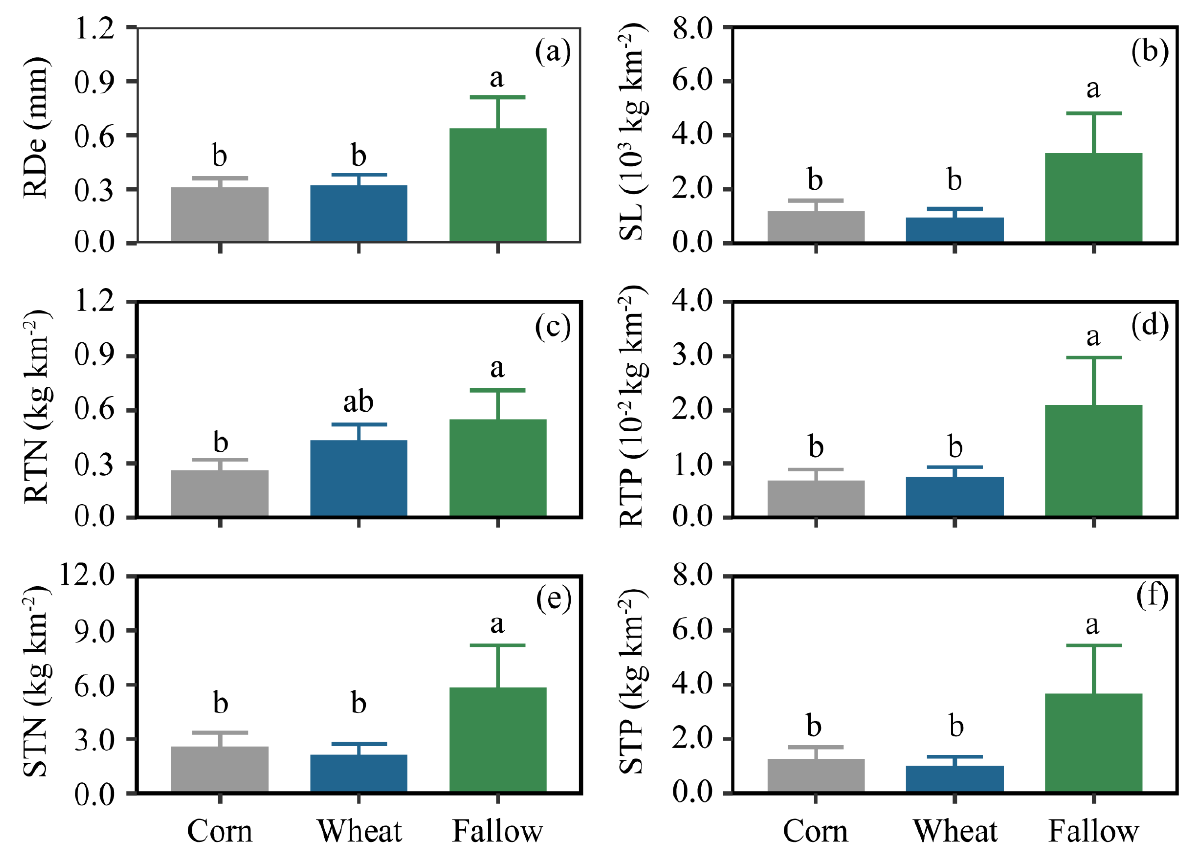
Figure 2. The ( a ) runoff depth (RDe), ( b ) soil loss (SL), ( c ) total nitrogen in runoff (RTN), ( d ) total phosphorus in runoff (RTP), ( e ) total nitrogen in soil loss (STN), and ( f ) total phosphorus in soil loss (STP) for spring corn, winter wheat, and fallow plots. Values followed by different letters above a column are significantly different at p ≤ 0.05. Different letters indicate significant differences between treatments.